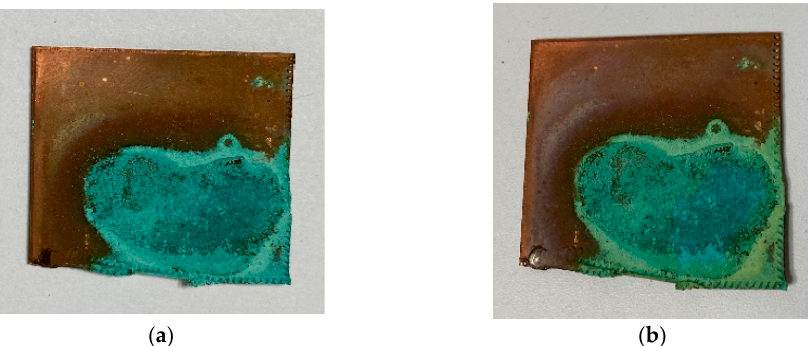
Figure 4. Copper sheets with copper nitrate patina before ( a ) and after reductive low-pressure plasma treatment ( b ). The plasma in fl uence led to a yellowish discoloration of the arti fi cial patina, which picture ( b ) shows.